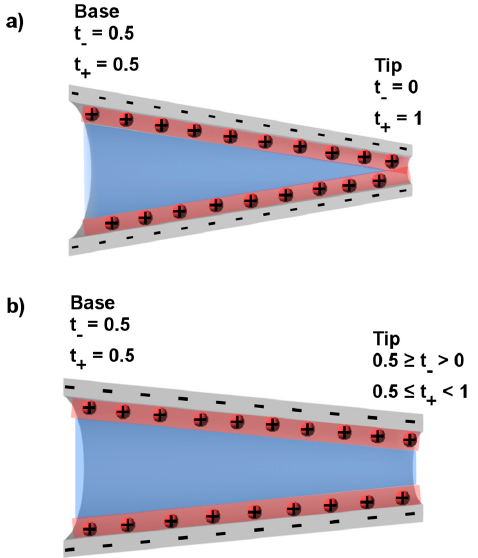
Figure 7. Schematic of conical pores ( a ) with the tip radius smaller or comparable to the double layer thickness and ( b ) with a tip radius larger than the double layer thickness. The double layer solution is represented by the red shading. The bulk solution is represented by the blue shading. Dimensions are not to scale.